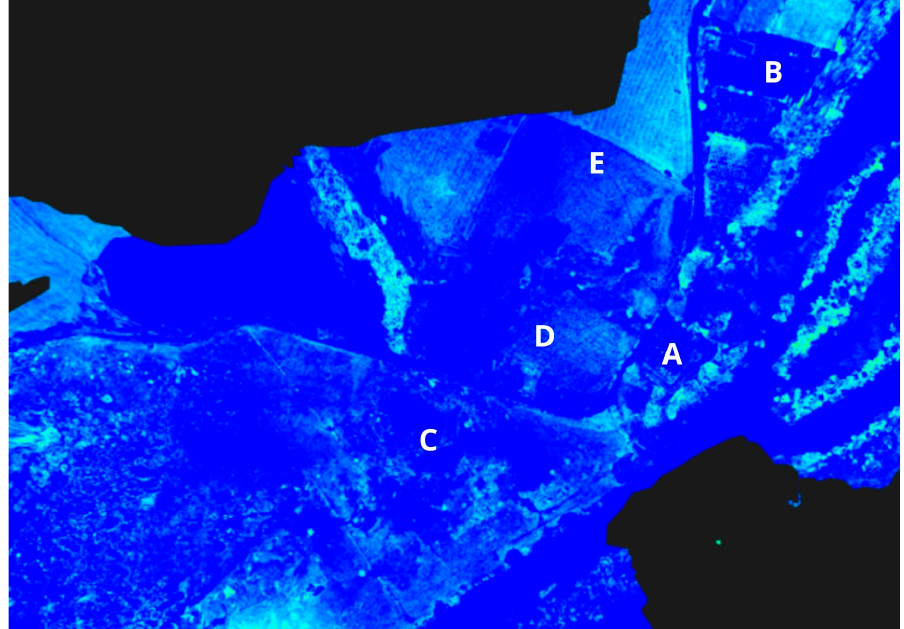
Figure 7. GNDVI analysis. Possible remains of Cruces Village and the San Luis del Alba Fort, October 2022. ( A ) San Luis del Alba Fort. ( B ) Possible remains of Cruces Village to the north of the fort. ( C ) Possible remains of Cruces Village to the south of the fort. ( D ) Mound or hill. ( E ) Cropmarks. Following the creation of titles for the land and of a land market since 18th century, the Spanish and mestizo populations in the area increased. Today, there is no indigenous community with titles in the San Luis del Alba Fort area, although there are Mapuche- Huilliche families in the process of organization. In 1822, at the very end of the War of Independence, the fort was a tt acked by Chilean forces, and it was destroyed by an earth- quake in 1837 [109] (p. 263). By 1860, the fort was in ruins, with one observer noting “ruins of an old Spanish fort, with trench rest, drawbridge, some old moldy cannon, over broken gun carriage”[117] (p. 345). In the early 20th century, Bauer noted that “it was said that there was a fort [beside the Cruces River] in the ancient times” [118] (p. 38). During inter- views, a local resident testi fi ed that during the fi rst half of the 20th century, the ruins were occupied by a militia paid by the landowners to prevent Indigenous a tt acks. In the 1960s, the Universidad Austral de Chile oversaw the reconstruction of the fort, using original Spanish plans, for the purpose of archeological research and heritage protection [119] (p. 176). The fort is now abandoned and closed to the public.